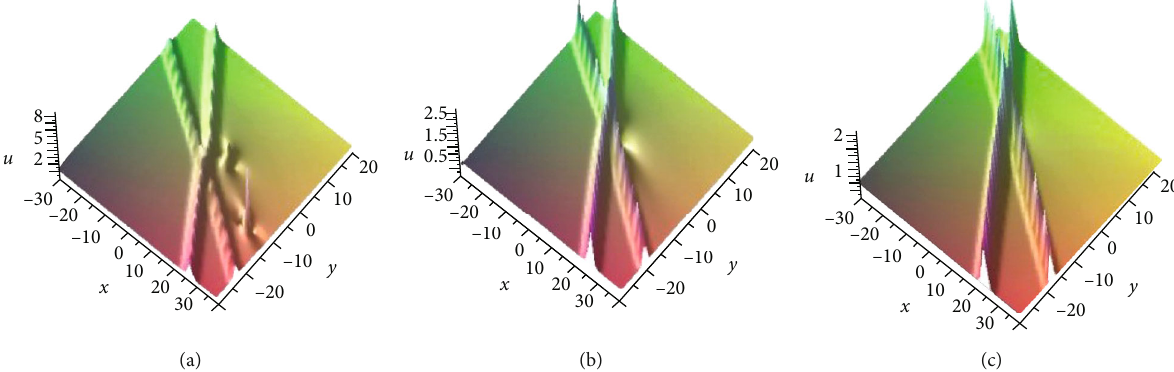
Figure 6: The high-order semirational solution u = 2 ln ð G Þ d 12 = 1 , C 11 = 1 , ξ 10 = η 10 = 0 : (a) t = − 2 , (b) t = − 0 : 2 , and (c) t = 2 .